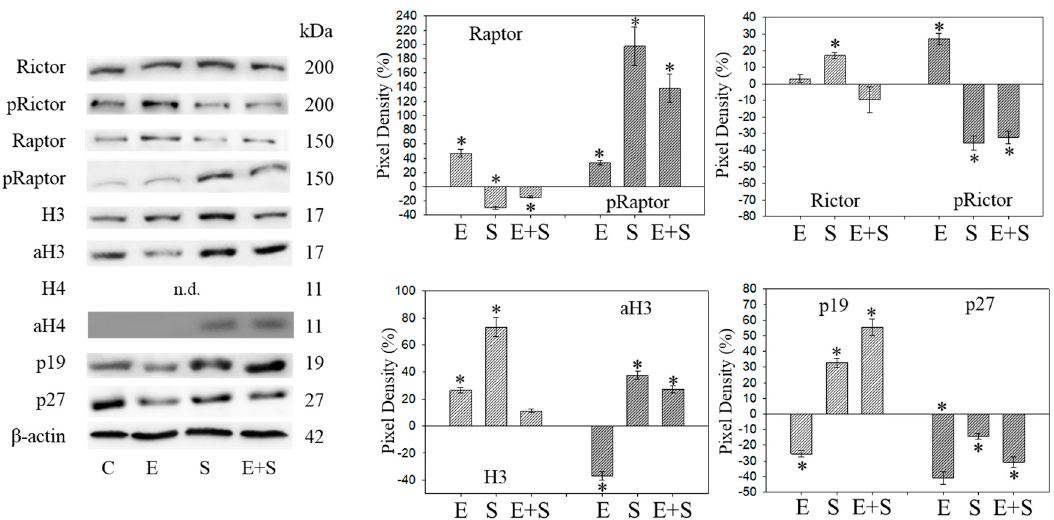
Figure 10. Protein profile of cell cycle regulating proteins (Rictor, Raptor, histone acetylation, p19, p27) after the long-term application of 0.5 nM everolimus (E) or 2.5 µM sulforaphane (S) or 0.5 nM everolimus + 2.5 µM sulforaphane (E + S) to synchronized RT112 tumor cells. Controls (C) received